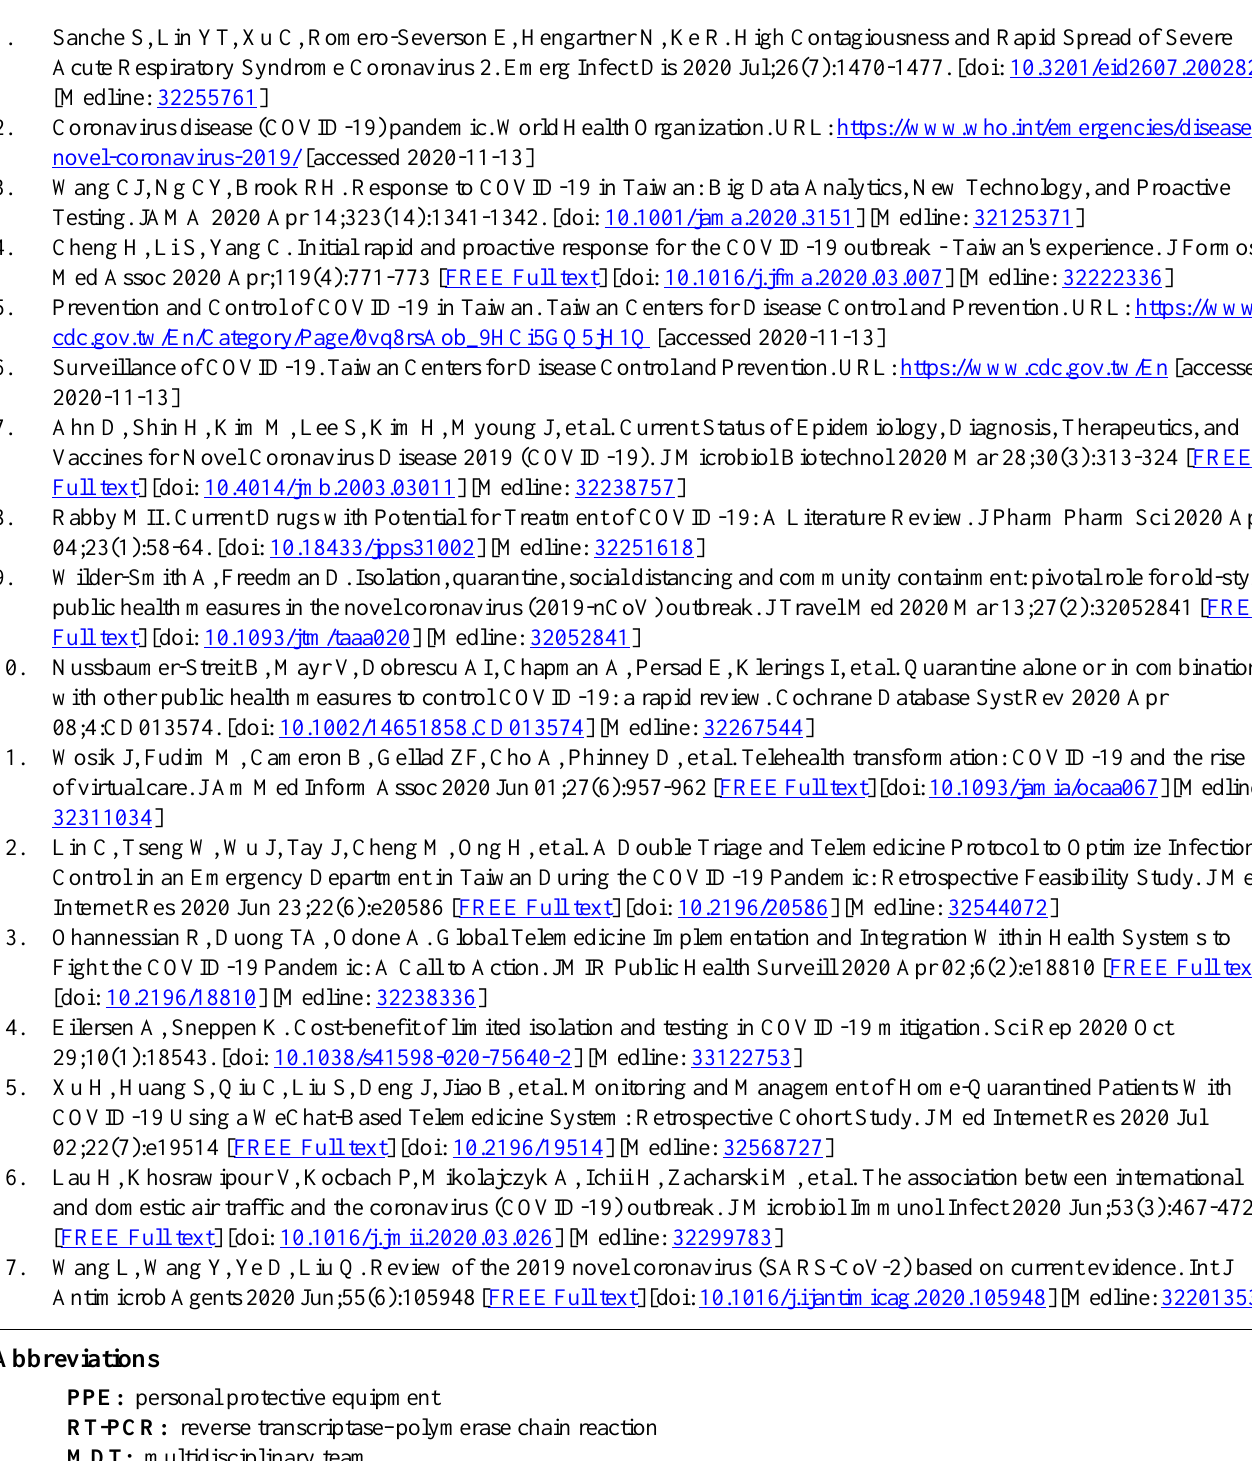
PPE: personal protective equipment RT-PCR: reverse transcriptase–polymerase chain reaction MDT: multidisciplinary